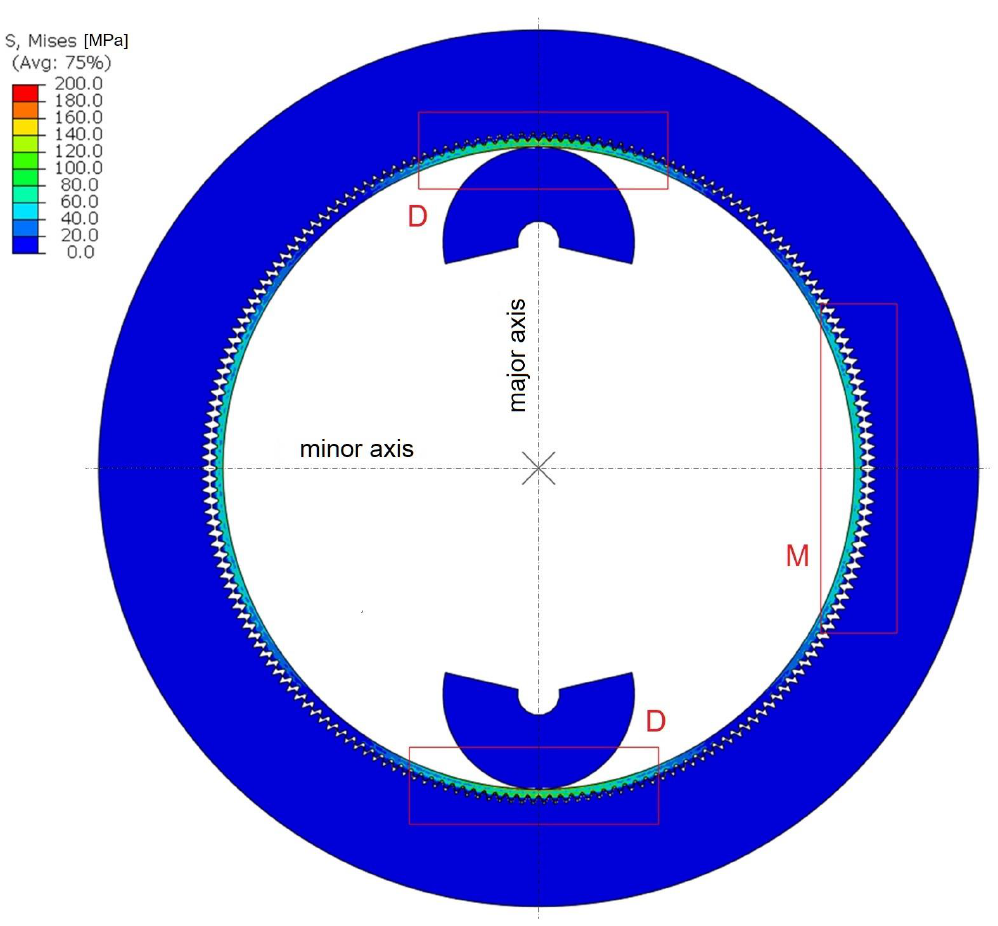
Figure 10. Stress distribution on the model of harmonic hermetic drive with the double-roller gen- erator.